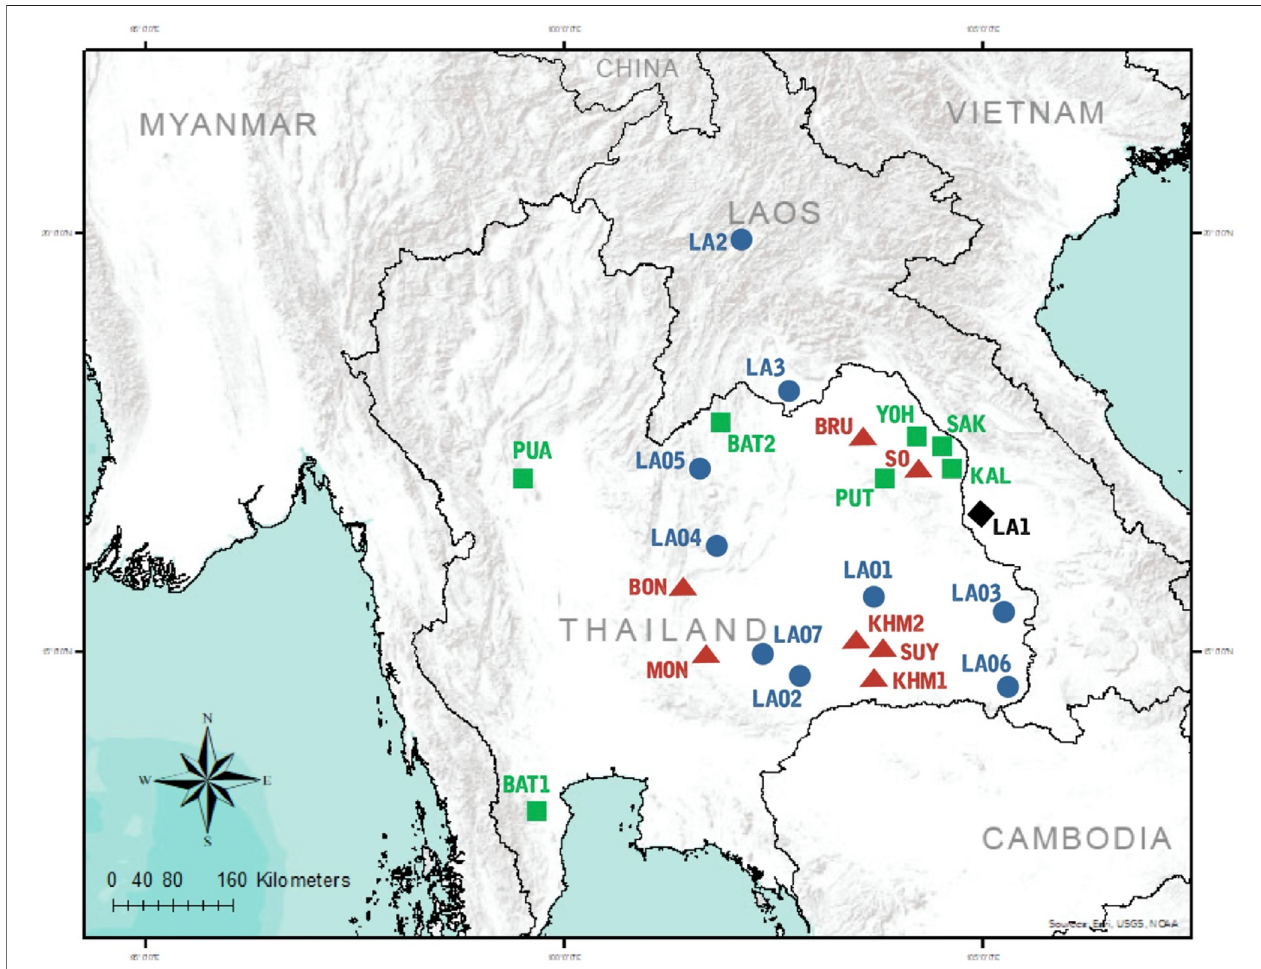
FIGURE 1 | Map of sampling locations. 10 populations were sampled in the present study, combined with data from 14 populations collected in previous studies. Population codes are given in . Supplementary Table S16 Black diamond, blue circles, green squares, and red triangles represent AA-speaking Laotian, ethnic Lao group, compared TK-speaking and AA-speaking populations